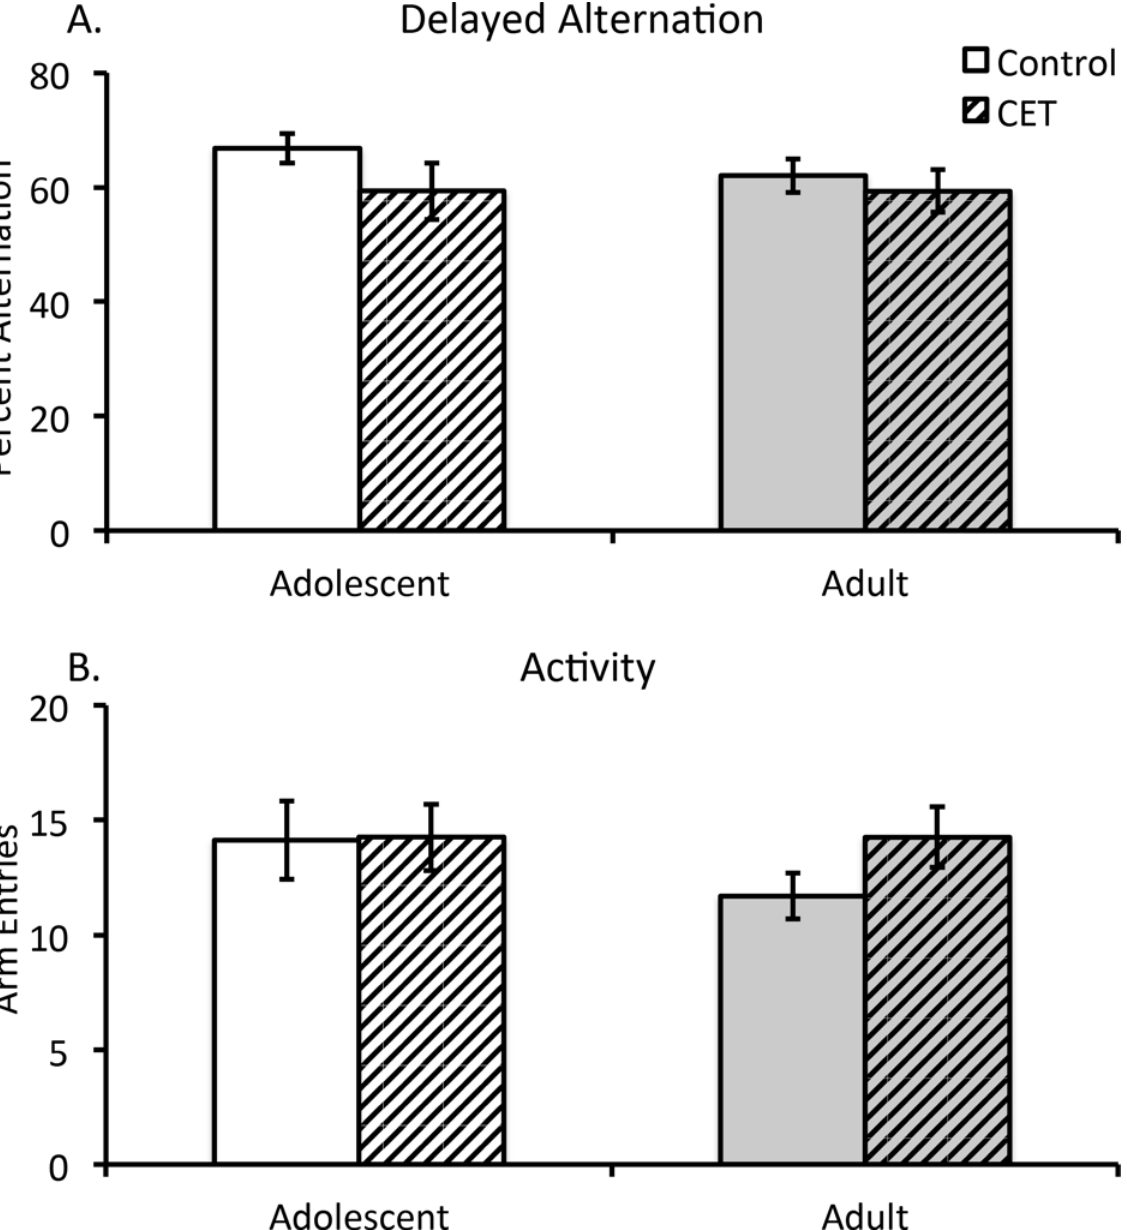
Fig 7. Chronic EtOH drinking did not impair delayed alternation behavior. (A) Average percent delayed alternation according to Age and Treatment conditions. There was no effect of Age or CET on delayed alternation performance. (B) Average number of arm entries according to Age and Treatment groups. No group differences were